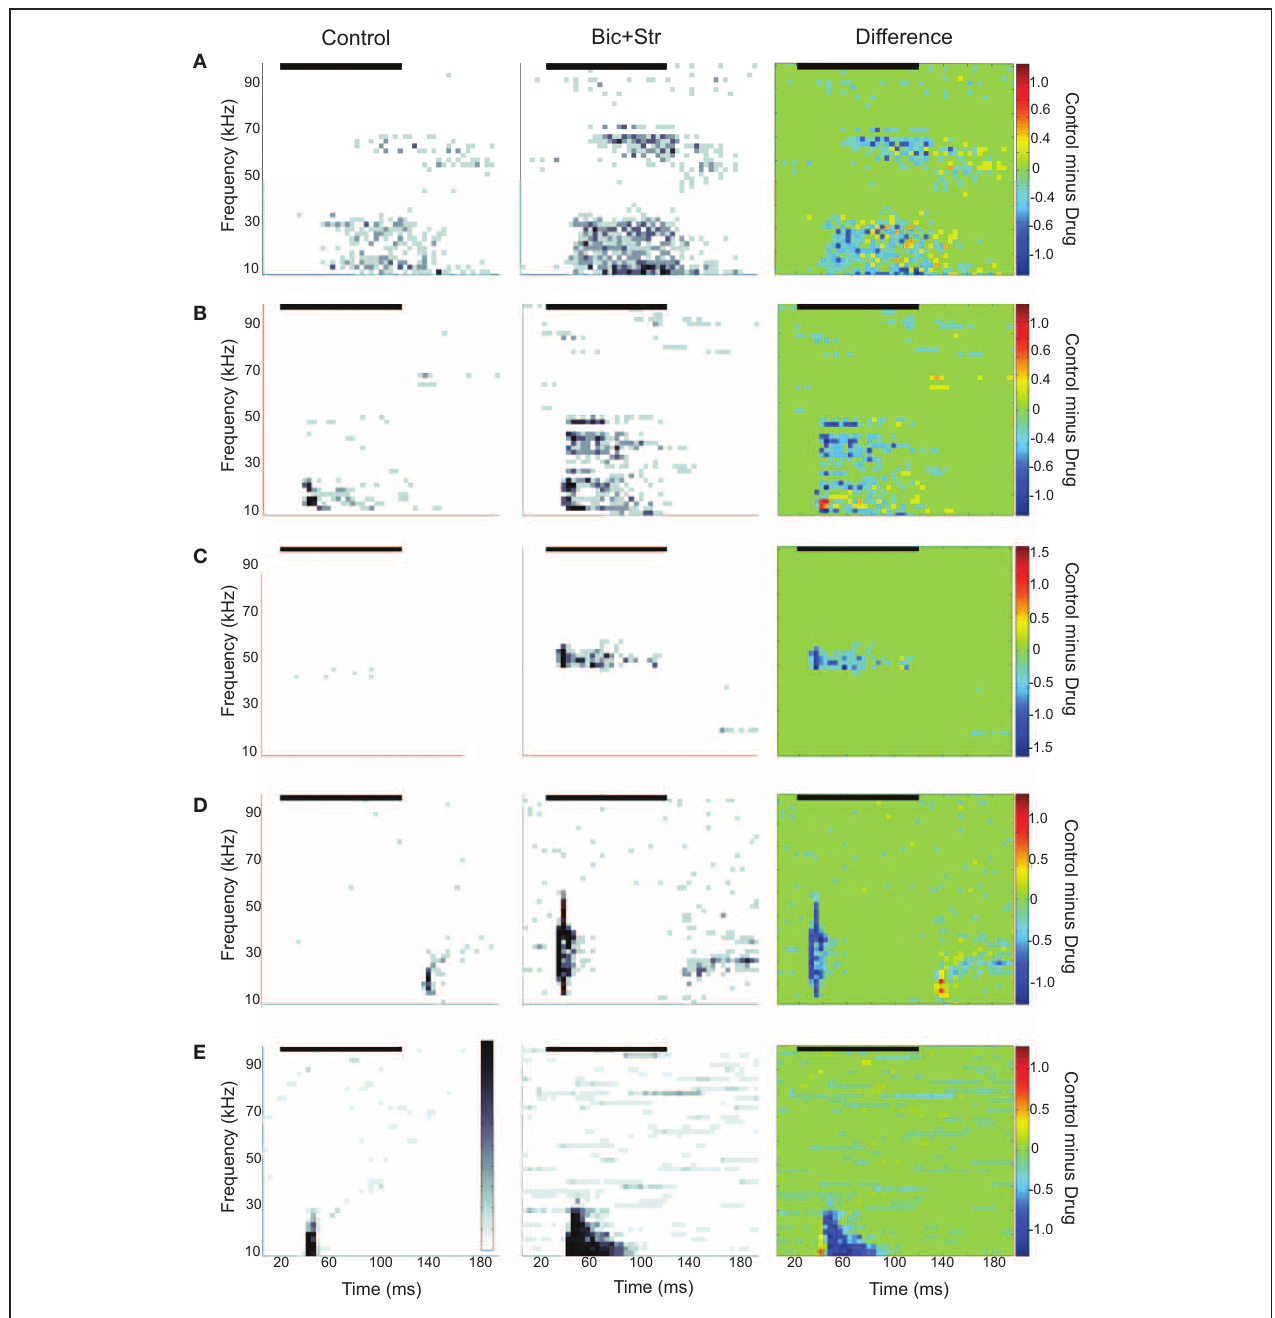
to tones without a broadening of the excitatory frequency tuning curve. (B) Increased rate and broadening of the excitatory frequency tuning curve. (C) Conversion of an O-shaped to a V-shaped excitatory frequency tuning curve. (D) Latency shift. (E) Conversion of an onset to a sustained evoked firing pattern. In all plots, the black horizontal line indicates the sound stimulus. Bin width is 4ms.